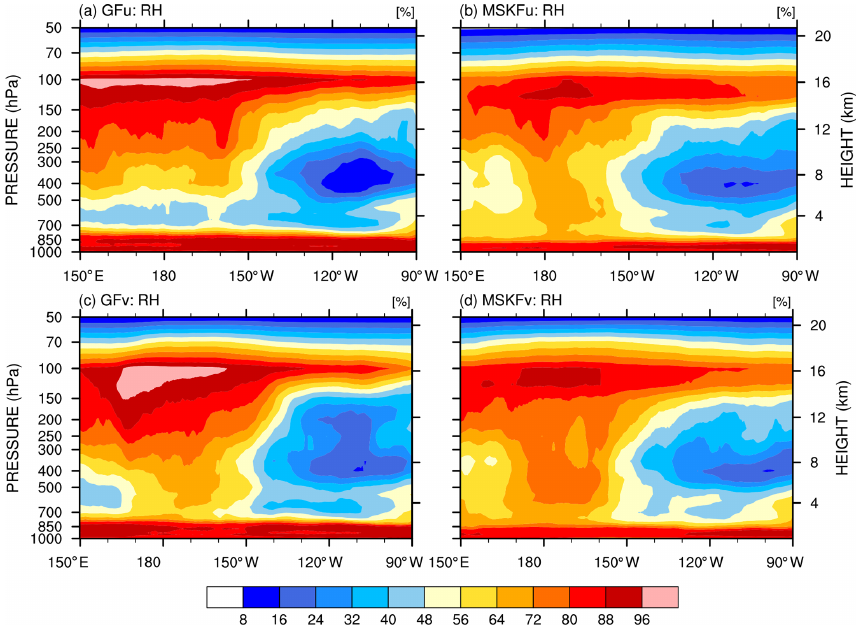
Figure 11. Longitude versus pressure cross section of latitudinally averaged (between 5 ◦ S and 5 ◦ N) relative humidity (RH) across the tropical Pacific Ocean simulated in (a, b) GFu and MSKFu and (c, d) GFv and MSKFv for December 2015.